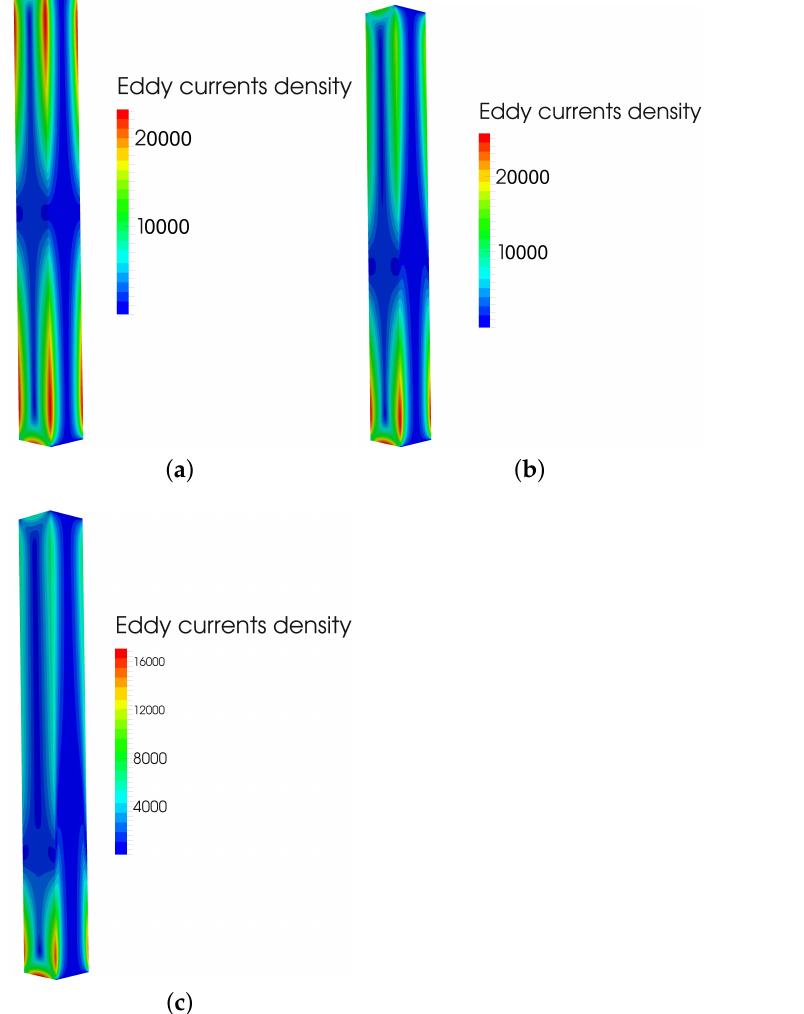
Figure 7. ( a ) Eddy current density at position 1 = 0 mm; ( b ) Eddy current density at position 2 = 20; and ( c ) Eddy current density at position 3 = 50 mm.